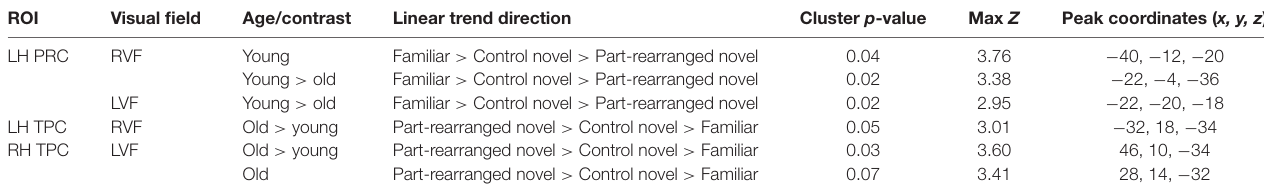
TABLE 2 | Clusters showing significant linear trend in the medial temporal lobe. ROI Visual field